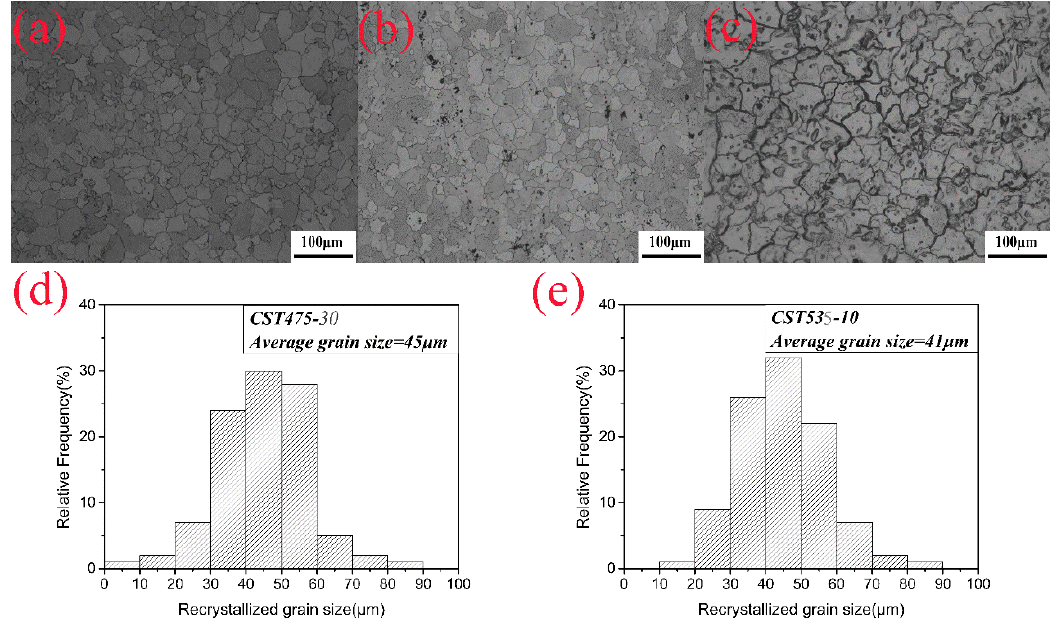
Figure 4. Optical microstructures of quenched specimens ( a ) CST475-30 ( b ) CST535-10 ( c ) CST555-10 ( d ) CST475-30 grain size distribution ( e ) CST535-10 grain size distribution.